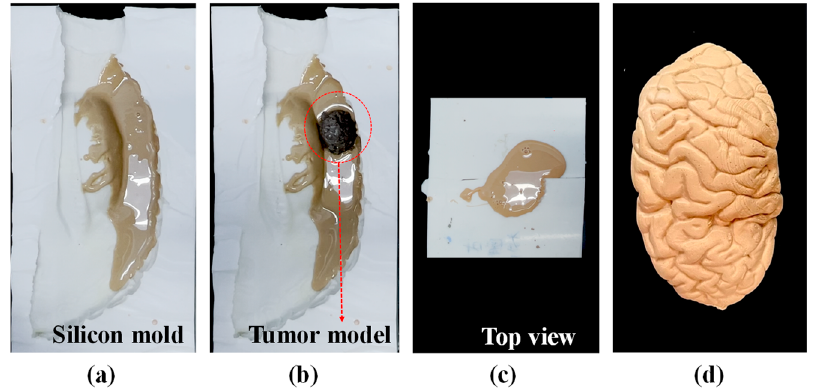
Figure 3. ( a ) A small quantity of jelly was poured into the silicon mold; ( b ) placement of preformed cerebral tumor within the jelly; ( c ) the cast was then closed, into which the remaining jelly mixture was poured; ( d ) finished right parietal lobe with embedded cerebral tumor.